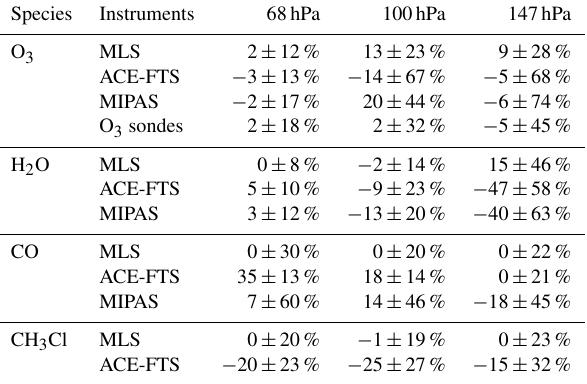
Table 3. Mean difference and standard deviation between BRAM2 and observations for the 2005–2017 period at three typical levels in the TTL: 68, 100 and 147hPa. Values are in percent, normalized by BRAM2. Abbreviations: not assimilated